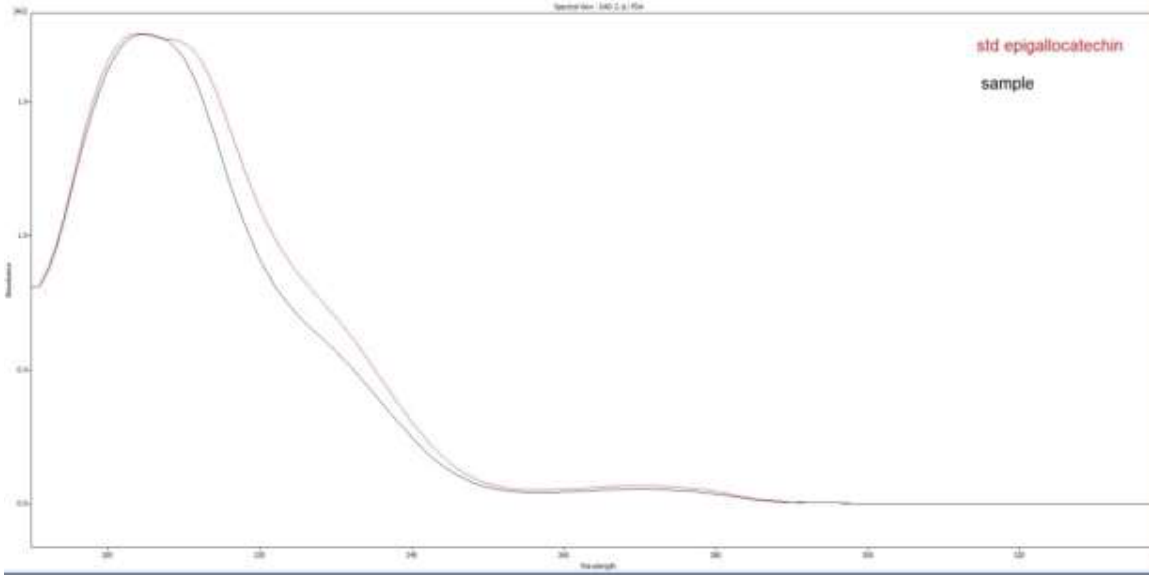
Figure2. UV spectrum of ethyl acetate fraction matched with standard UV spectrum of epigallocatechin.